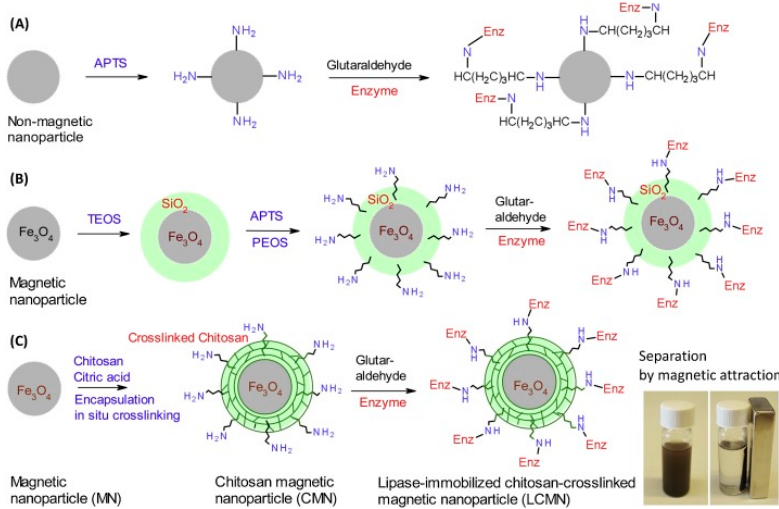
Figure 6. Representative illustrations of enzyme immobilization in the nanoparticle. ( A ) Conventional method using non-magnetic nanoparticle. ( B ) Conventional method using magnetic nanoparticle and organosilane compounds. ( C ) Present study using magnetic nanoparticle and chitosan crosslinked for immobilization of enzyme (lipase). APTS: 3-aminopropyltriethoxysilane, TEOS: tetra-ethoxy silane, PEOS: poly-ethoxysilane. Reprinted from Hosseini et al. [21], with permission from Elsevier. Copyright (2018) Elsevier B.V. ( A ) and ( B ) modified by Hosseini et al. [21] from Kim et al. [62], an open access